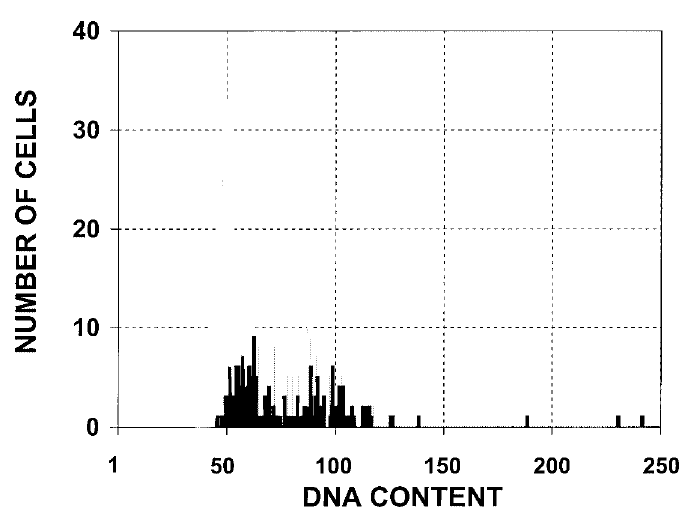
Fig. 3. The DNA content of 520 randomly measured cells (gray) of which 152 were TK1 positive (black). Fluorescence image cytometry of double stained PC-3 cells (TK1-Texas Red, DNA-DAPI).